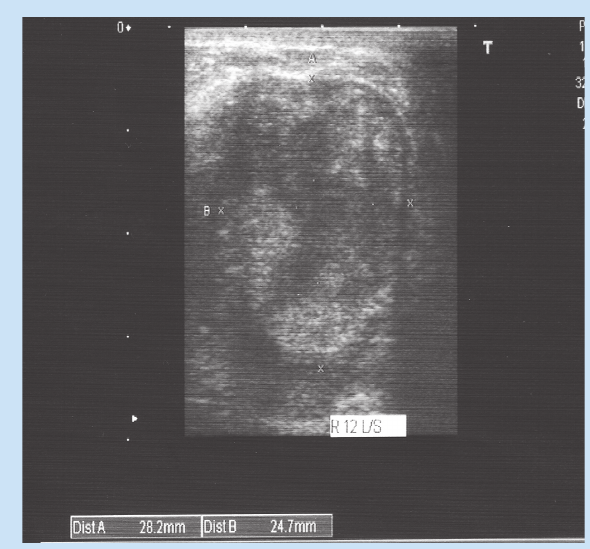
Fig. 4. Chest radiograph: Enlarged cardiac shadow shows enlarged right atrium and ventricle. Filling in of the aorto-pulmonary window is suggestive of pulmonary hypertension. Patchy consolidation of the right lower lobe.